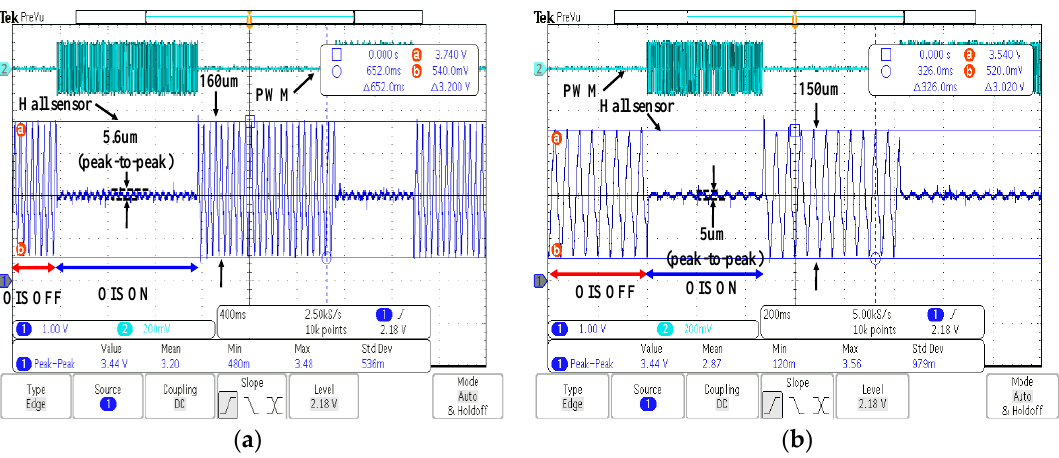
Figure 12. Experimental results with the controller simultaneously applied to x and y directions of the OIS. ( a ) Experimental result in x direction; ( b ) Experimental result in y direction.